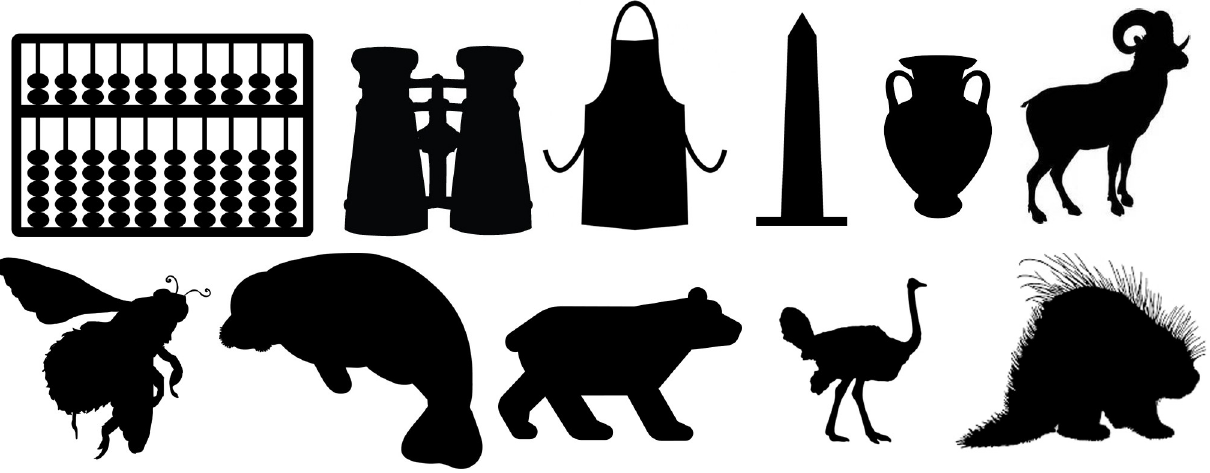
Fig 18. Sample stimuli used in Experiment